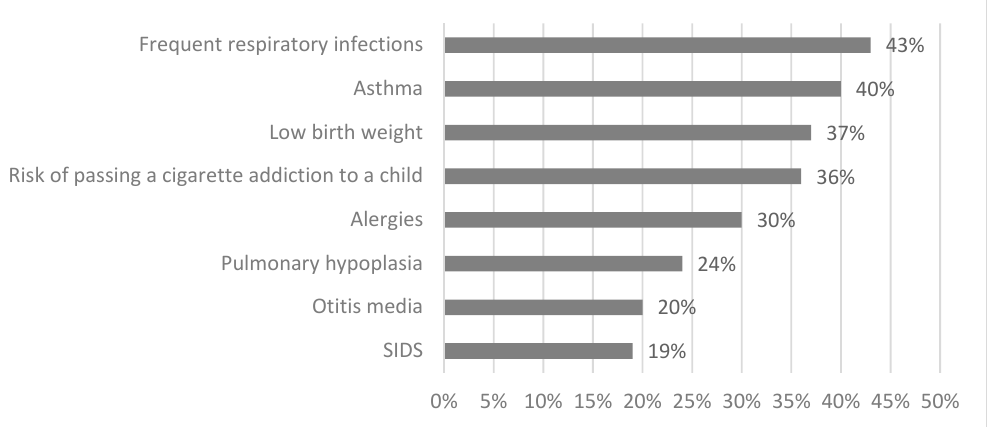
Figure 3. Negative health effects of SHS exposure among children-parental beliefs.